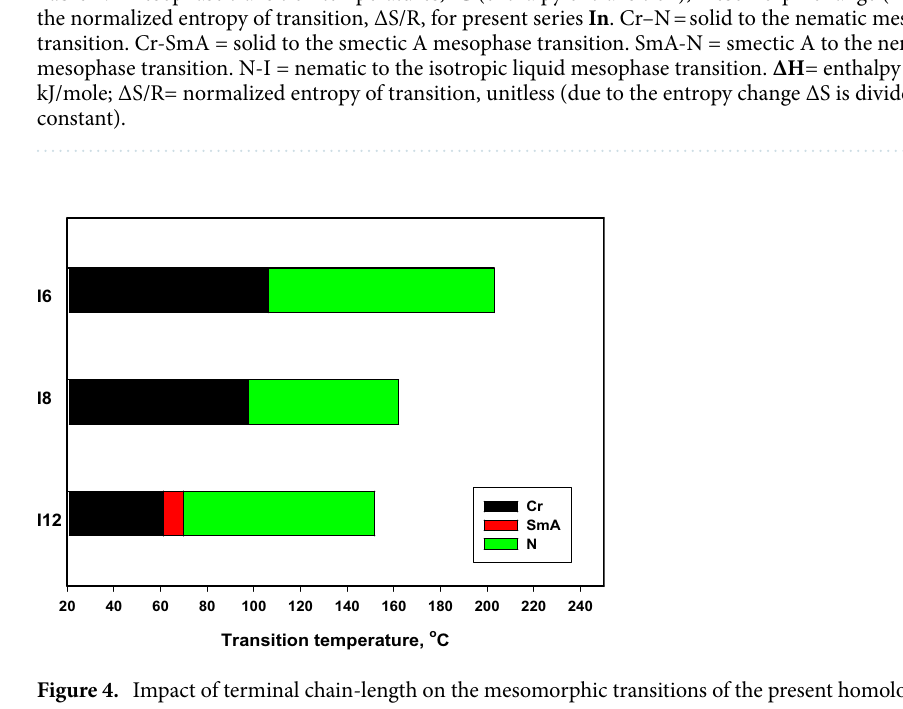
Figure 4. Impact of terminal chain-length on the mesomorphic transitions of the present homologue, I-n